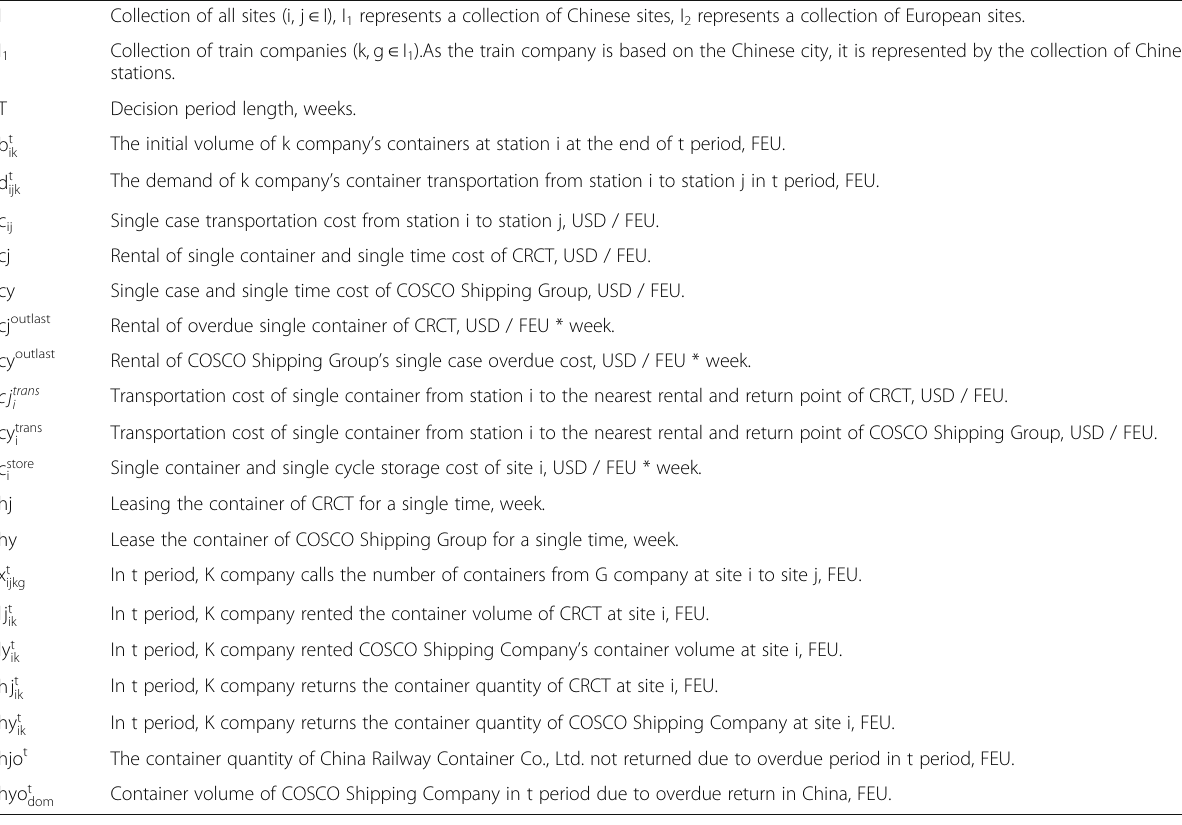
Table 1 Description of parameters and variables parameters